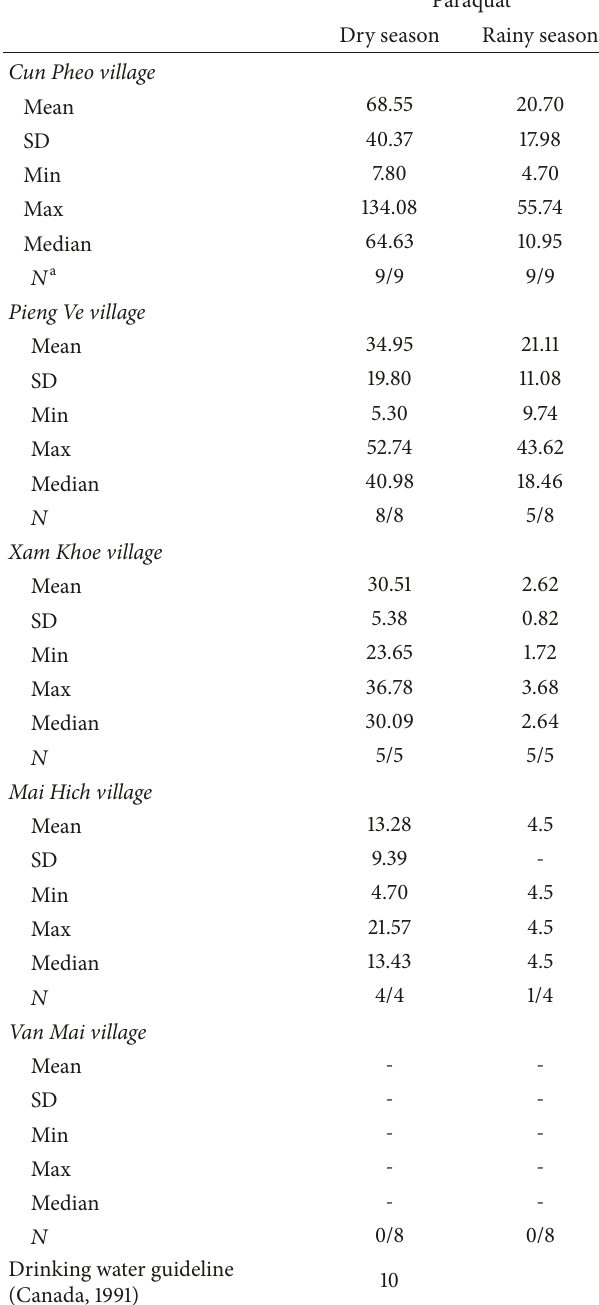
Table 1: Concentrations of paraquat ( 𝜇 g/L) in the surface water samples in five villages (Cun Pheo, Pieng Ve, Xam Khoe, Mai Hich, and Van Mai) at Mai Chau province in the Northern